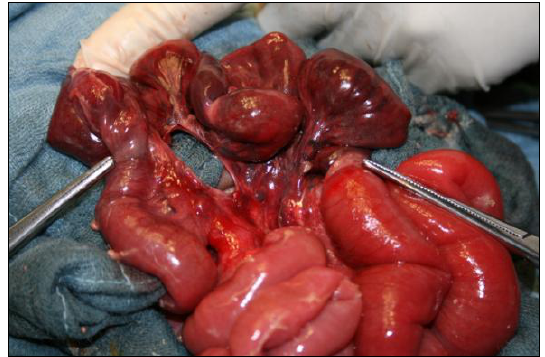
Figure 1: Intraoperative findings after reduction, a round mesenteric defect in the segment of the jejunum with gangrenous